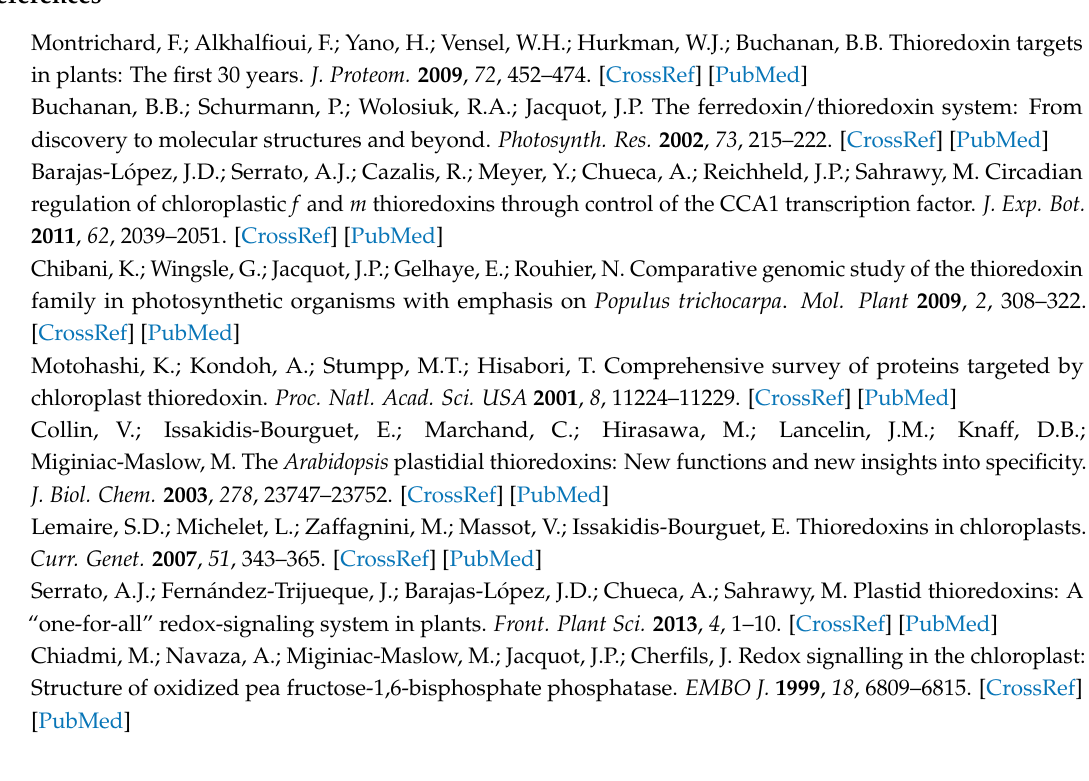
Table S1: gene-specific oligonucleotides used for quantitative PCR, Table S2: list of identified proteins in trxf1 , trxf2 trxm1 , trxm2 , txm3 , and trxm4